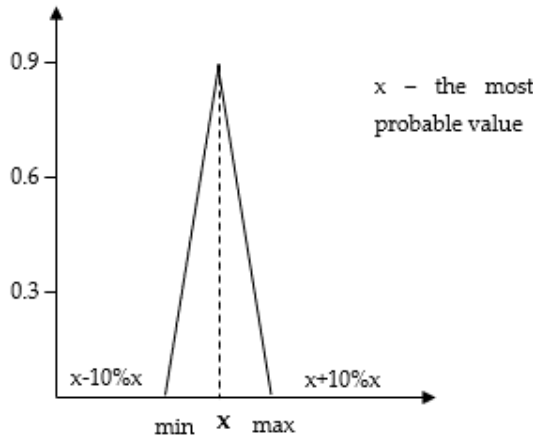
Figure 2. Dependence between the ADQI value and the shape of the triangular distribution curve in the process of polylactic acid bottle manufacturing. Table 3. Sample electricity test results specified for the preform stretching and extending process.